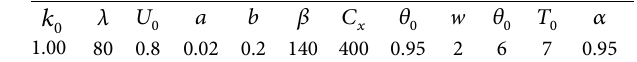
Table 6: Parameter set.